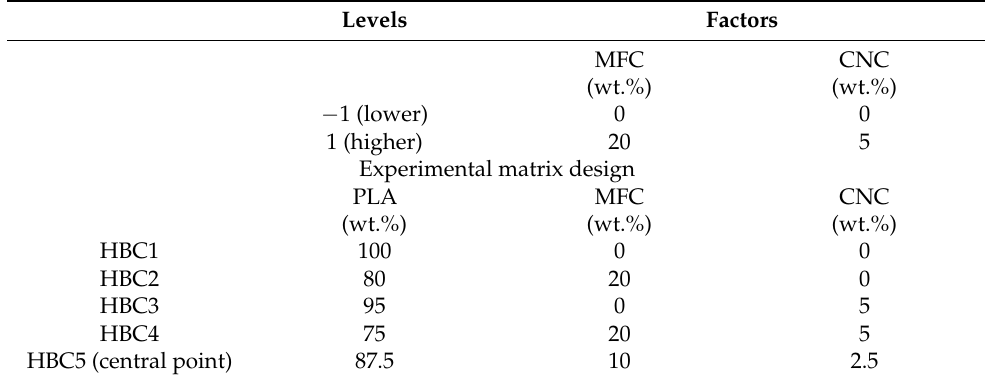
Table 1. Factor levels and experimental design